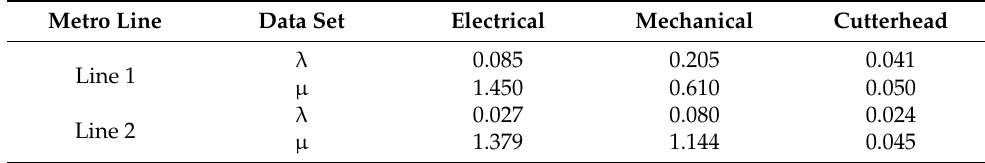
Table 9. Comparison of λ and µ of subsystems in Lines 1 and 2.